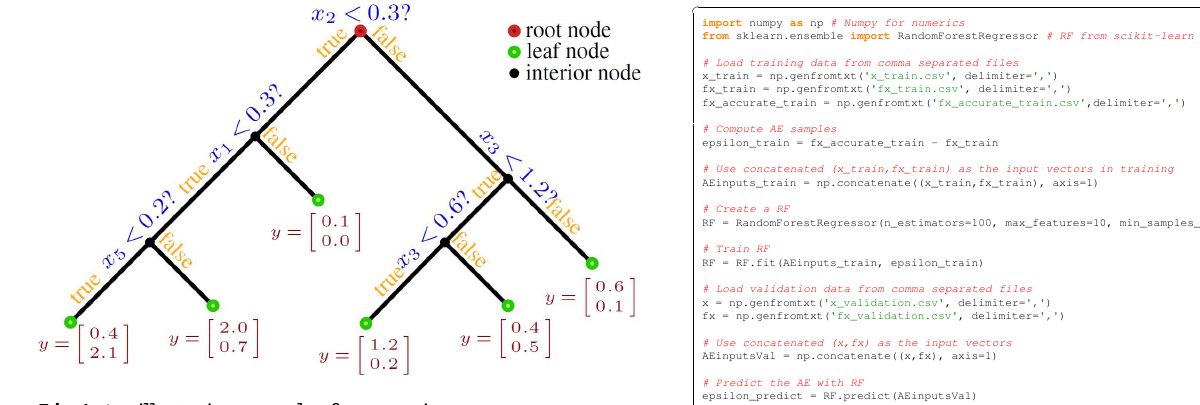
Fig. 1. An illustrative example of a regression tree.